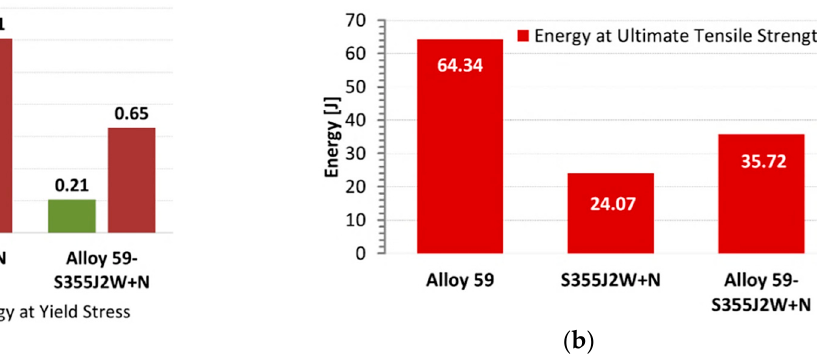
Figure 19. Energy at mechanical parameters for Alloy 59, S355J2W+N steel and the mixed weld calculated based on the tensile curves from Figures 13–15. ( a ) for the elastic limit and yield stress ( b ) for the ultimate tensile strength.